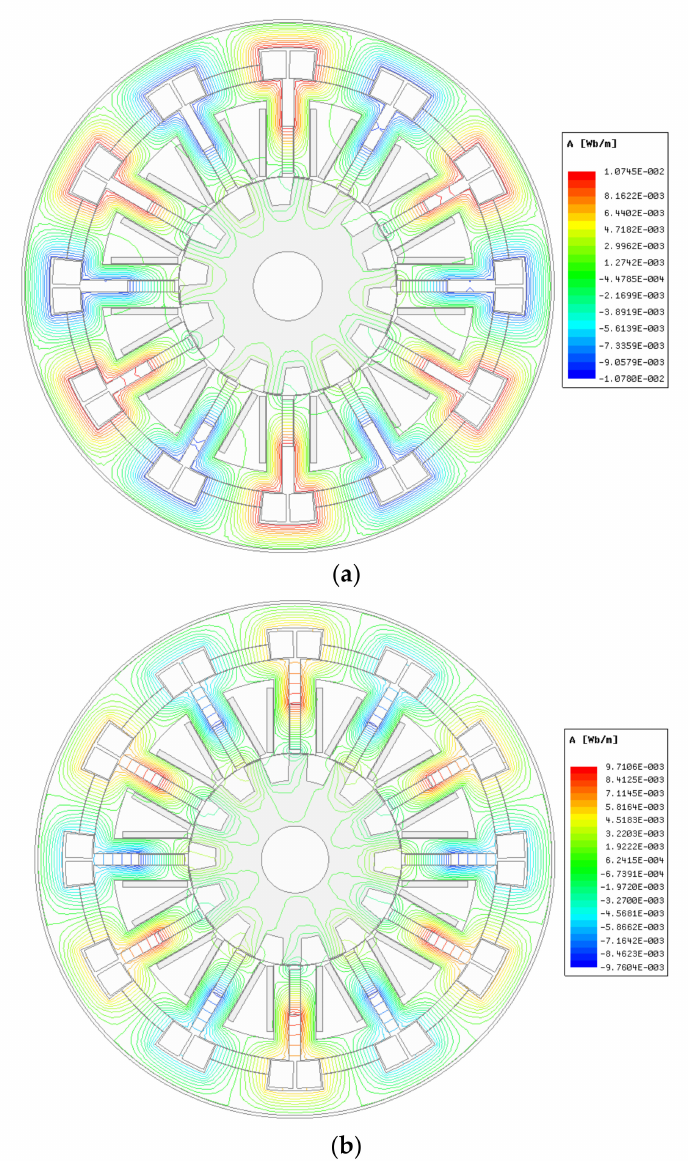
Figure 3. Magnetic potential distribution of the VFMPM machine. ( a ) Weakened flux condition; ( b ) Enhanced flux